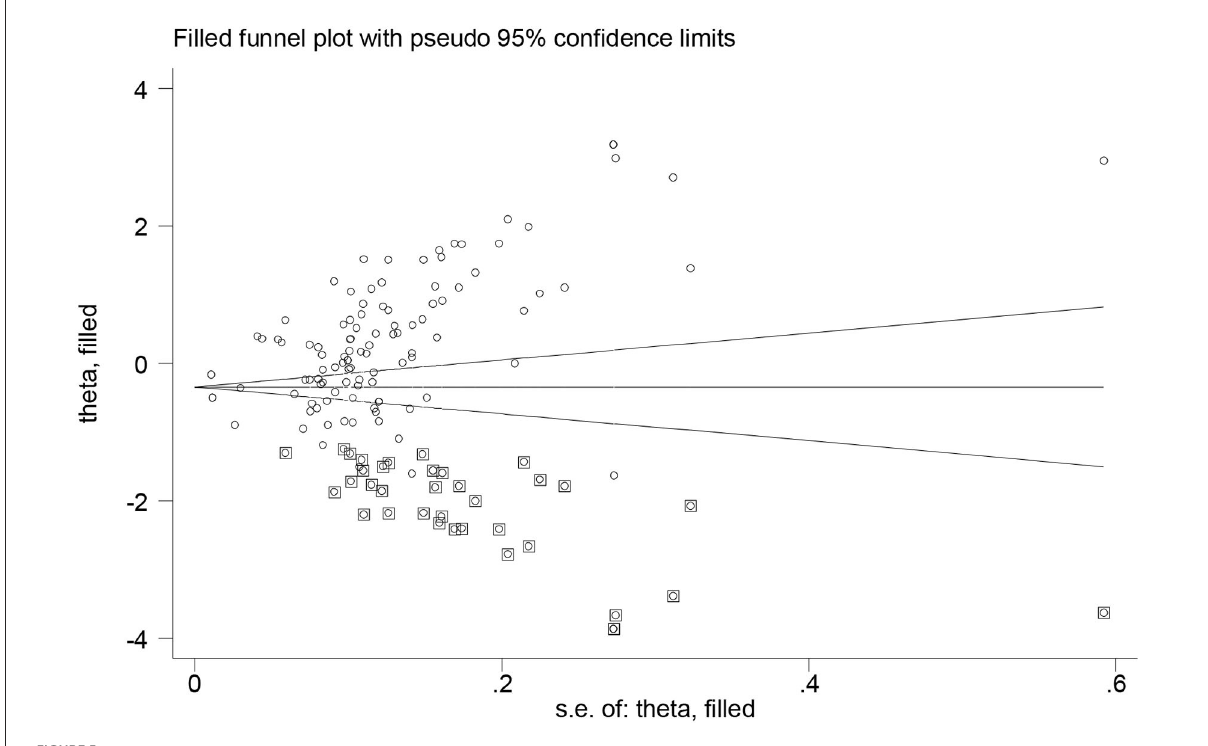
FIGURE5 Funnel plot for publication bias with trim and fill